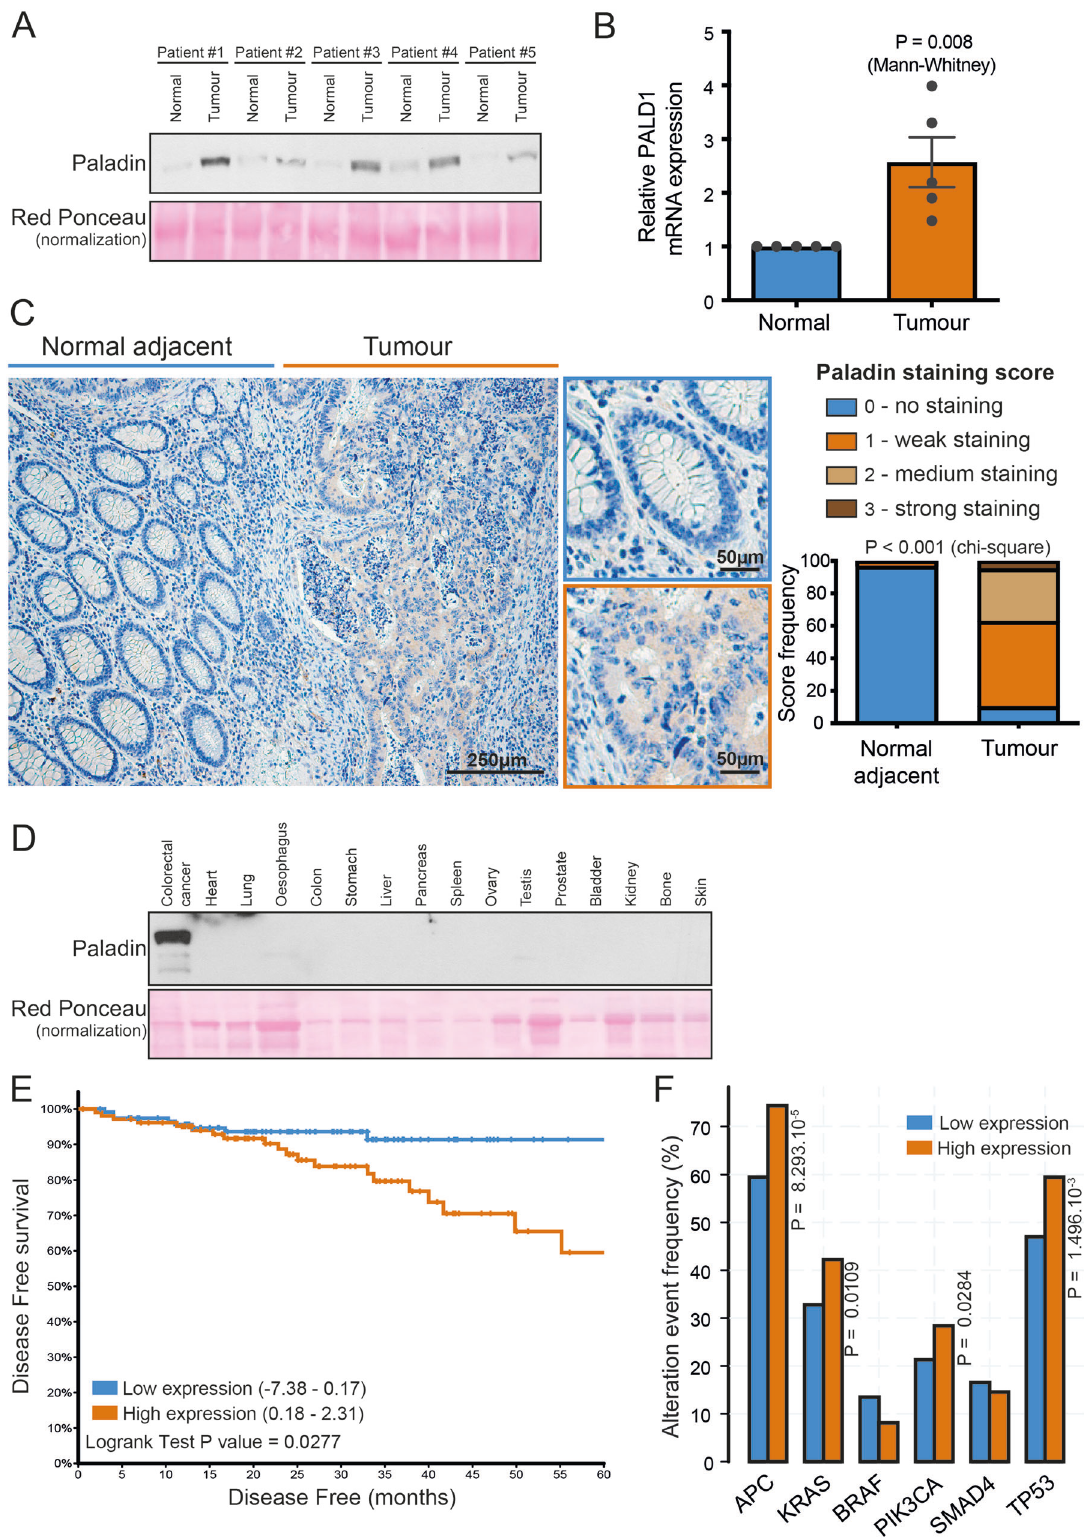
(Fig. 4D, supplementary tables 5 and 6). By grouping these enzymes based on function, we identi fi ed a potentially altered pathway involved in cell migration (Fig. 4E), which included co fi lin, the main regulator of actin dynamic